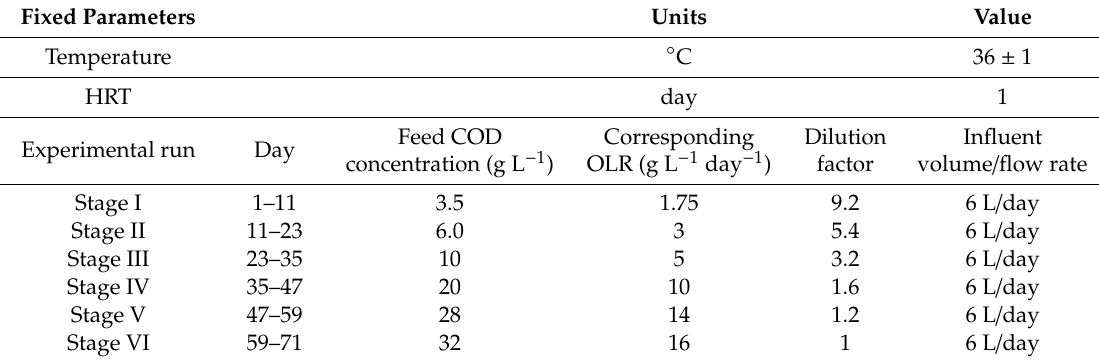
Table 2. Startup strategy of conventional and modified UASB reactors.